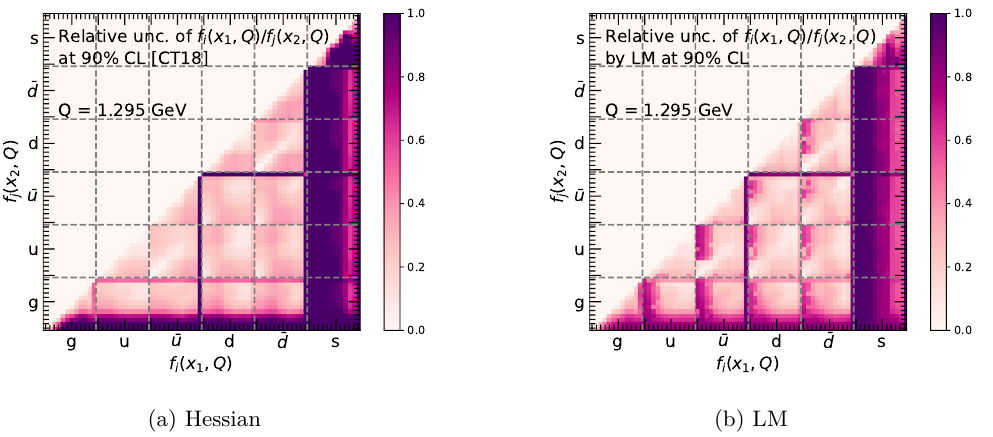
Figure 9 . The relative uncertainties of R f = f i ( x 1 , Q ) /f j ( x 2 , Q ) determined with the Hessian method and the LM method at 90% CL are shown in panel (a) and (b) respectively. The color code represents the relative uncertainties of the ratio R . The relative uncertainties are calculated at f Q = 1 . 295 GeV with x 1 and x 2 selected among 12 values from 3 × 10 − 5 to 0.6 listed in table 3, and ¯ i, j ∈ { g, u, ¯ u, d, d, s } runs over all parton flavors.